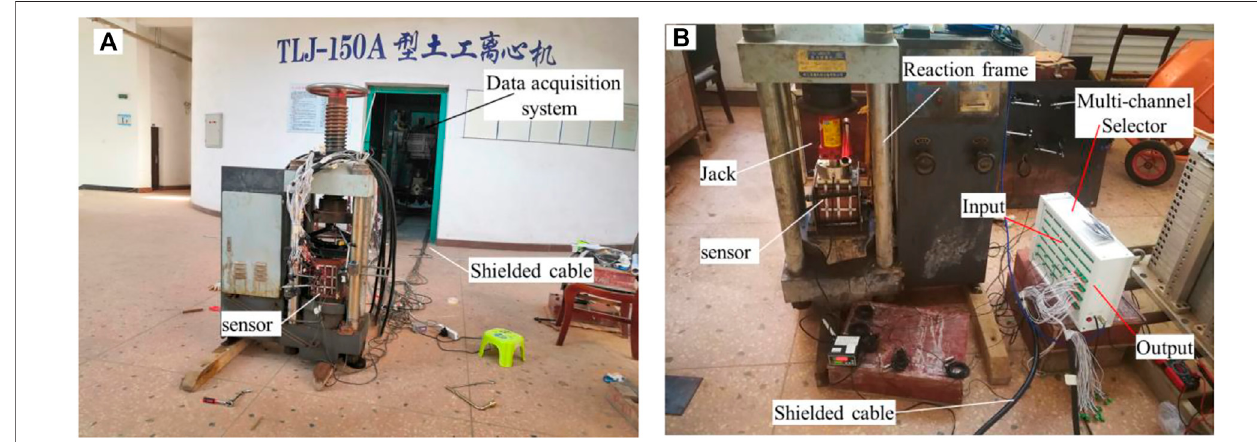
FIGURE 7 | Cable connection diagram for the static pressure model test.